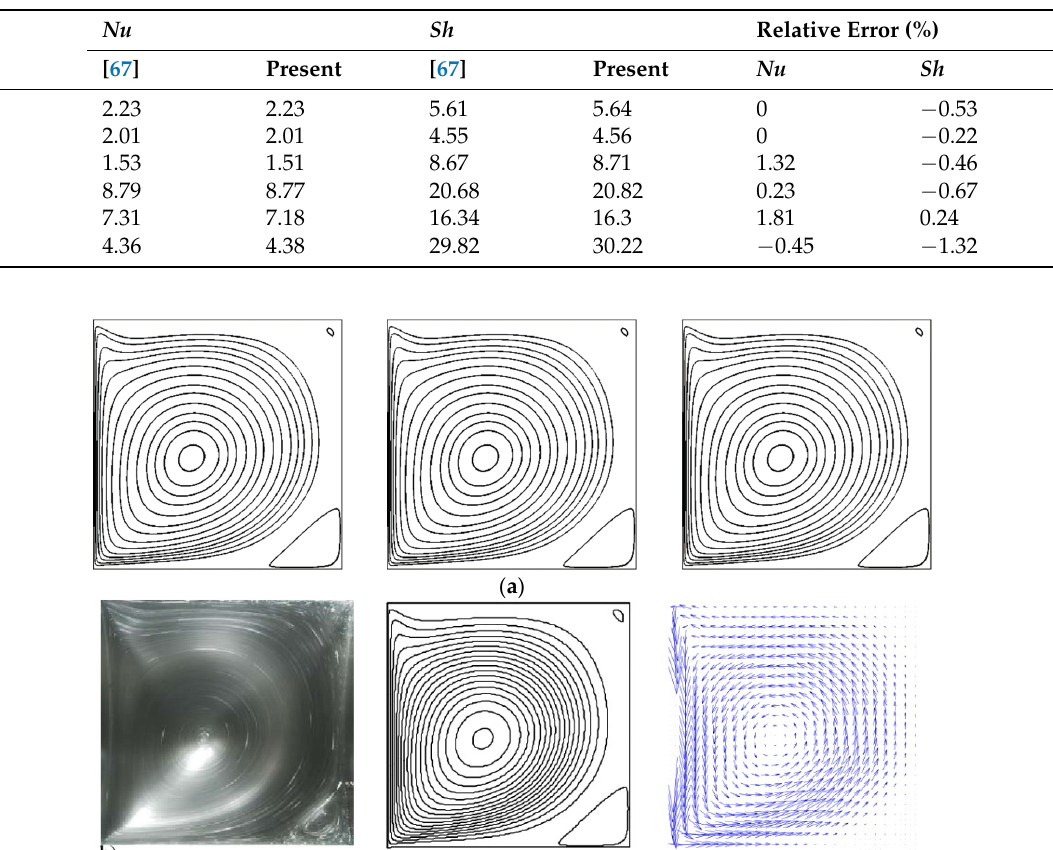
Table 2. Grid independence at different Da number and Ri